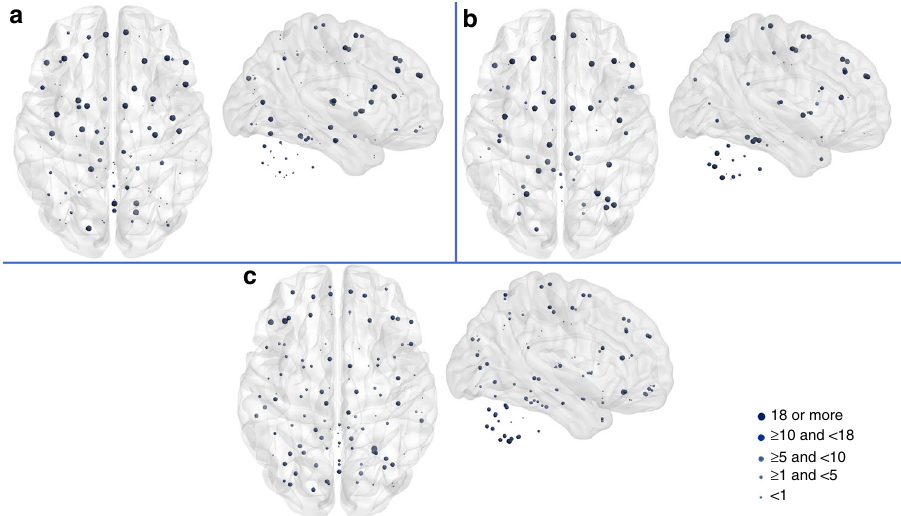
Fig. 2 Brain areas with the highest nodal measures appearing consistently across the participants, using lower resolution connectivity matrices (116 ´ 116) generated using the AAL atlas and MGH-USC DSI datasets. The top 25% nodes are shown for curvature ( a ), strength ( b ), and betweenness centrality ( c ). Here, the largest spheres indicate nodes with high values in 18 out of the 33